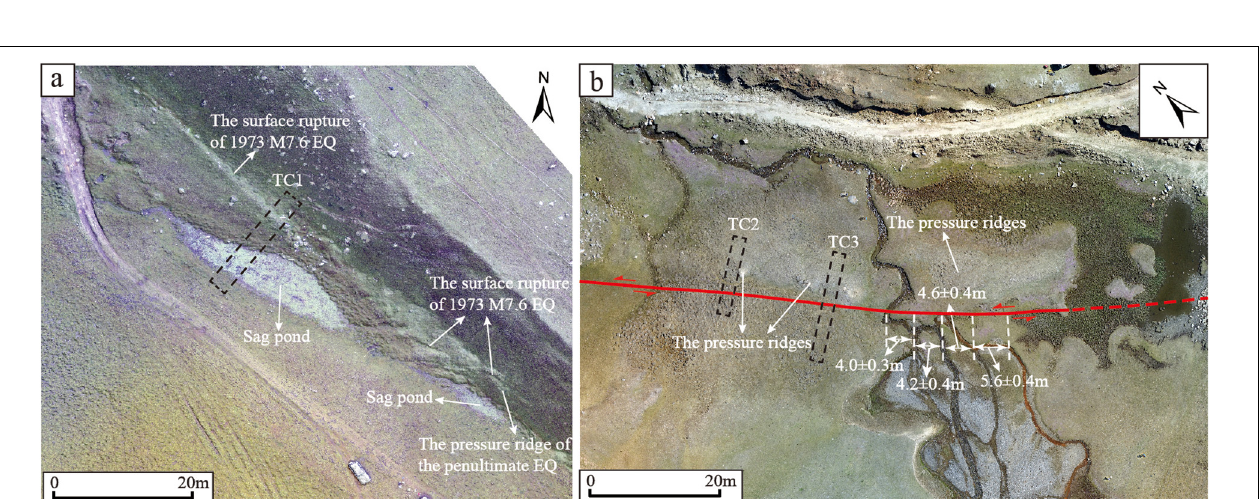
Frontiers in Earth Science |